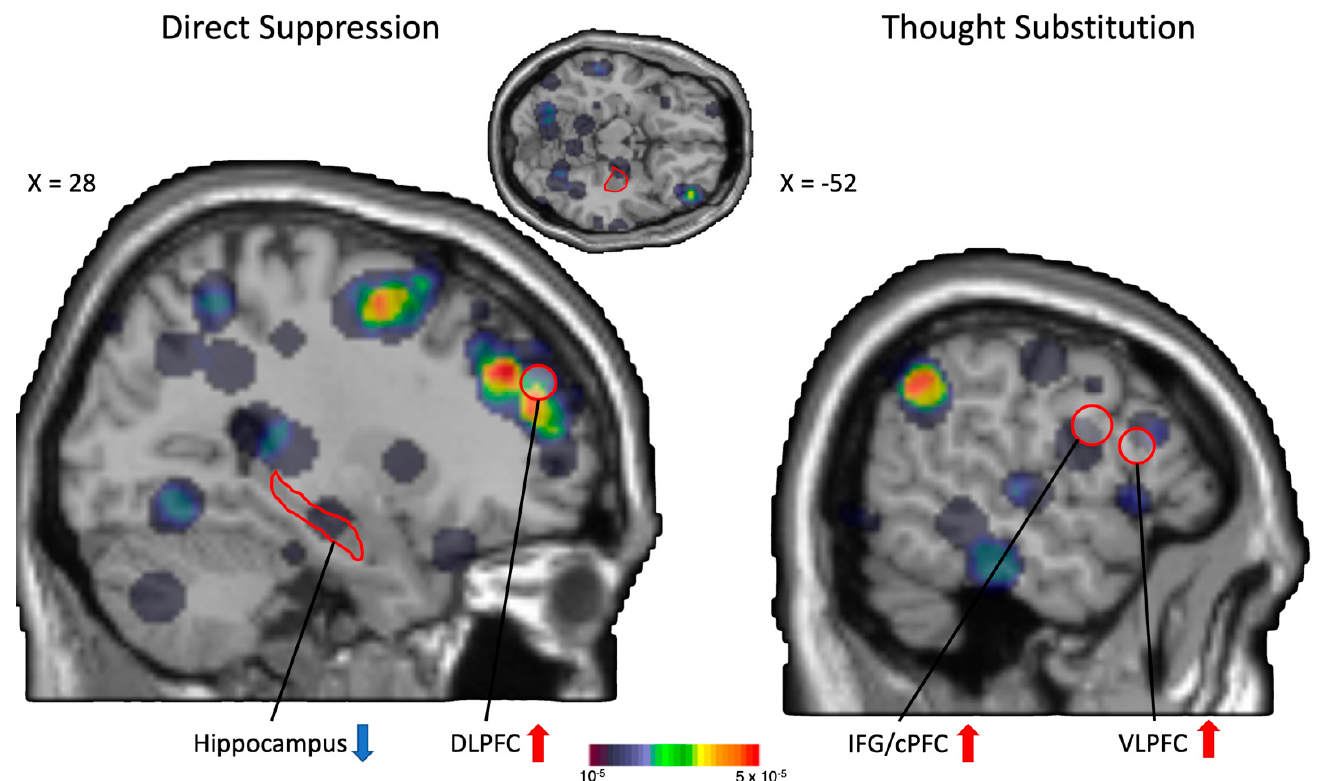
Figure 2. Distinct neural systems for direct suppression and thought substitution, as proposed by Benoit et al. (2012). They proposed that direct suppression involves recruitment of DLPFC and disengagement of hippocampus while thought substitution recruits IFG (caudal PFC) and VLPFC (ROIs in red enclosures, red upward arrows represent hypothetized engagement of brain regions whereas blue downward arrows represent hypothetized disengagement of brain regions). Results from our LDA analysis was overlaid on the MNI anatomical template. We observed distributed activities in all ROIs being mentioned. Here we treat direct suppression and inhibition are interchangeable